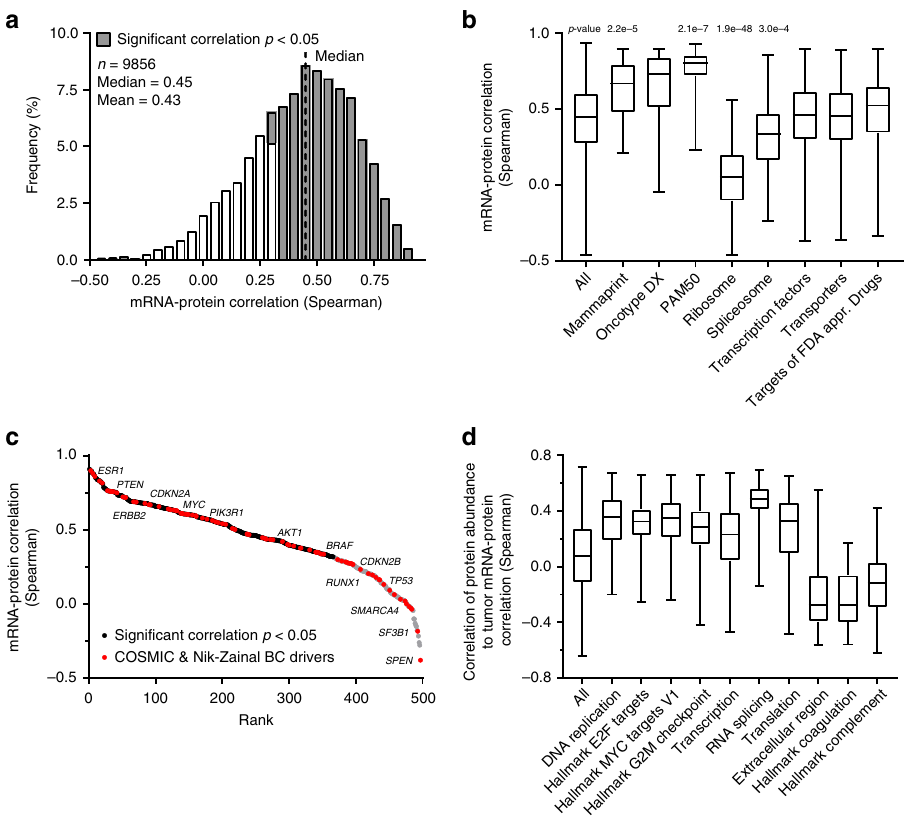
Fig. 5 RNA – protein correlation analysis. a Correlation between protein and mRNA quantitative values (Spearman) of individual genes. b Distribution of mRNA – protein correlations for selected groups of genes. Gene groups were compared with all correlations using Mann – Whitney U test. For additional gene groups and mRNA – protein correlation analysis considering data distribution, see Supplementary Fig. 10, 11, and Supplementary Data 4. c Ranked mRNA – protein correlations for genes causally associated with cancer (COSMIC) 28 and breast cancer (Nik-Zainal) 29 . d Gene ontology and hallmarks enriched at the top or bottom of proteins associated with tumor mRNA – protein correlation. All visualized protein groups have a p -value enrichment below 1E-17 using Mann – Whitney U test. In box plots, center line represents median and the boxed region represents the fi rst to third quartile, whiskers indicate the maximum and minimum